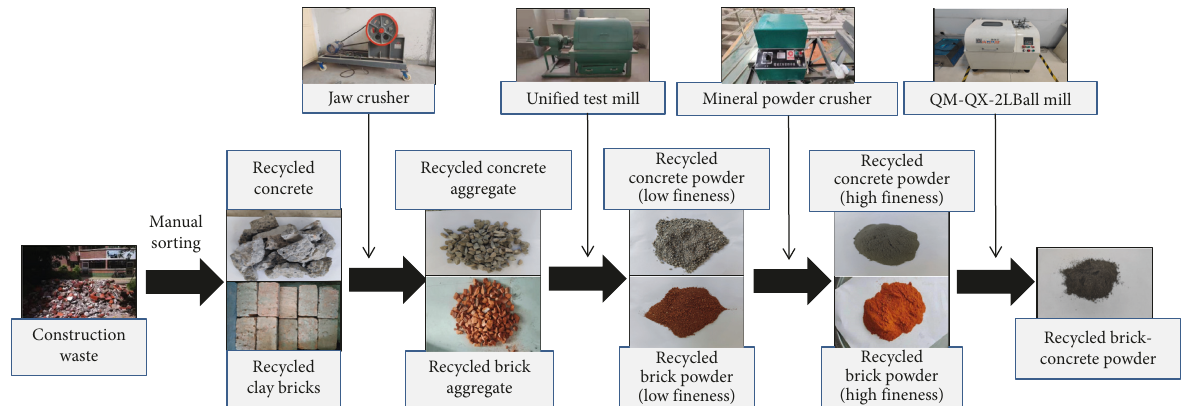
Figure 1: Preparation method of recycled aggregate and micropowder from C&BW. Table 1: Design of orthogonal